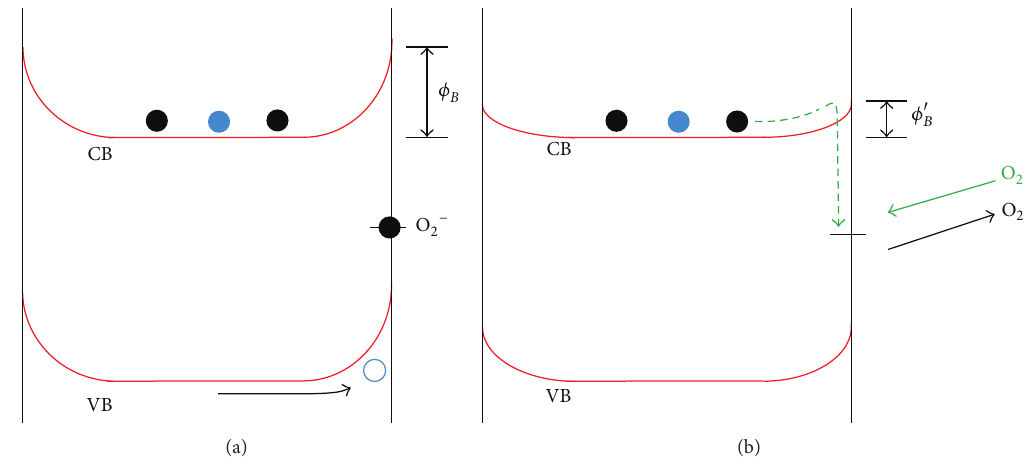
Figure 5: (a) The photogenerated electrons and holes in a ZnO nanowire are separated due to the built-in electric field cause by the band bending. The life-time of the pair is thus increased and the photoconductivity rises fast; (b) as the excitation process continues, the energy barrier at the surface lowers and oxygen molecules can readsorb. This leads to an equilibrium between adsorption and readsorption and as a consequence the photo-current saturates. In both figures, the color of photogenerated-carriers is blue, whereas other electrons in the conduction band determine the intrinsic n-type conductivity of ZnO and are indicated in black. The green arrows describe the retrapping of electrons and the oxygen